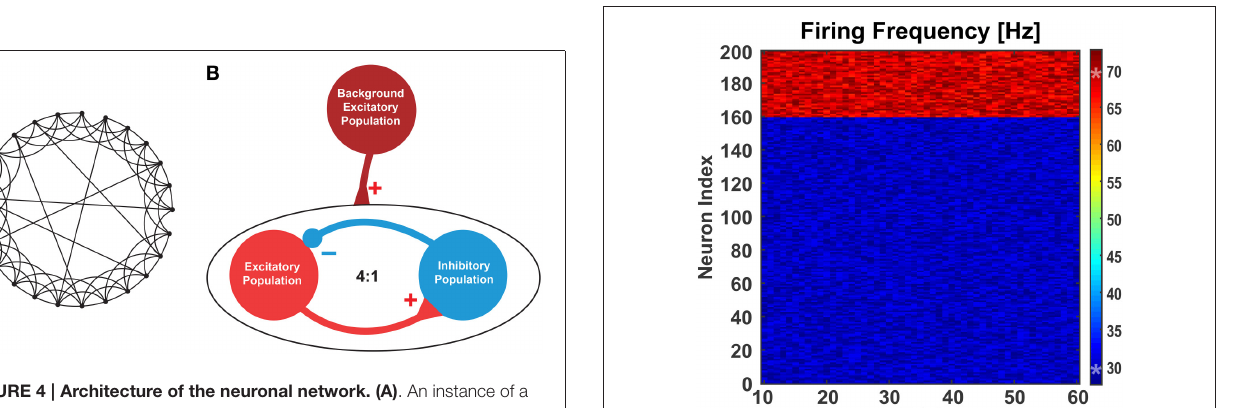
FIGURE 4 | Architecture of the neuronal network. (A) . An instance of a representative small-world network with 25 nodes out of which 6 ( K ) nodes were linked via random rewiring with probability p = 0.24 . (B) . A network consisting of excitatory ( E ) and inhibitory ( I ) neurons at 4 : 1 ratio was created with E → E , E → I , I → E , and I → I synaptic connectivity. To mimic the background activity or driving force, another population of excitatory neurons was used (maroon circle). This background population provided excitatory inputs to 50 % of the excitatory (red circle) and inhibitory (blue circle) neurons to maintain a stable firing pattern. The excitatory-inhibitory population consisted of total N ( = 200 , E = 160 , I = 40 ) neurons, each randomly connected to other K ( = 33 ) neurons with p ( = 0.165 ) connection probability using undirected edges creating a small-world network as described in Watts and Strogatz (1998).